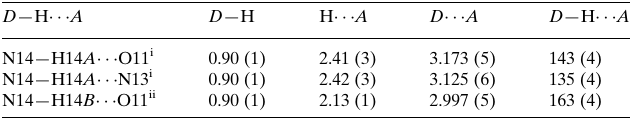
Hydrogen-bond geometry (A˚ , (cid:2)